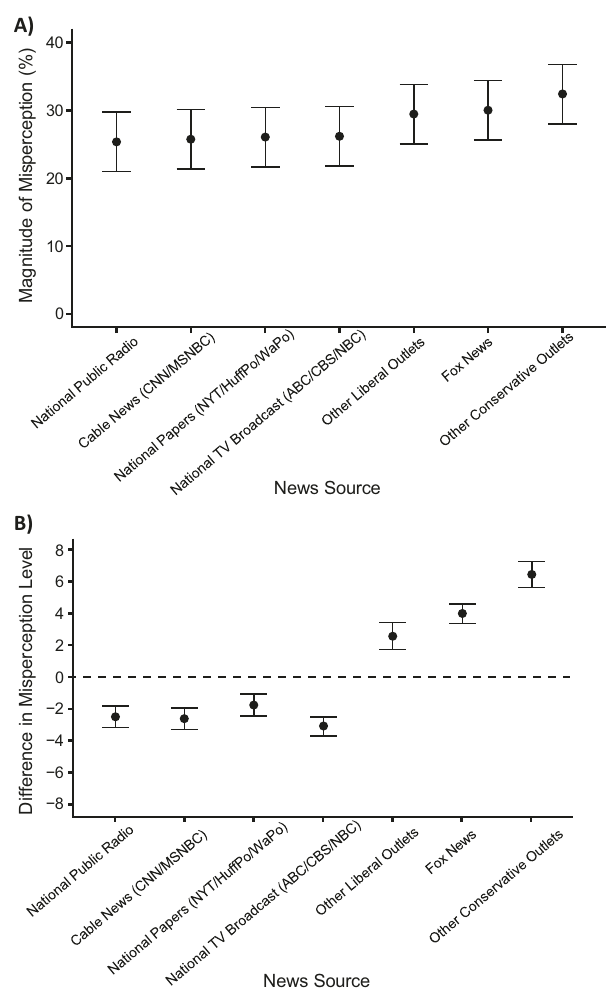
Fig. 5 | Pluralistic ignorance and news media consumption. A shows pluralistic ignorance levels for consumers of each news media source. B Shows effects on pluralistic ignorance levels comparing consumers to non-consumers of each news media source (zero=baseline levels of misestimates). Estimates in both panels are obtained from a mixed model contrasting viewers and non-viewers of each news source and controlling for participants ’ demographics. Pluralistic ignorance levels of N =6119 participants are calculated by taking the difference from real and per- ceived levels of policy support and climate concern (greater values indicate real levelsarehigherthanperceivednorms,i.e.greaterunderestimationinperception), andcontrollingforthebatteryofdemographicsassessed(seeMethods).Errorbars are 95% con fi dence intervals of the means